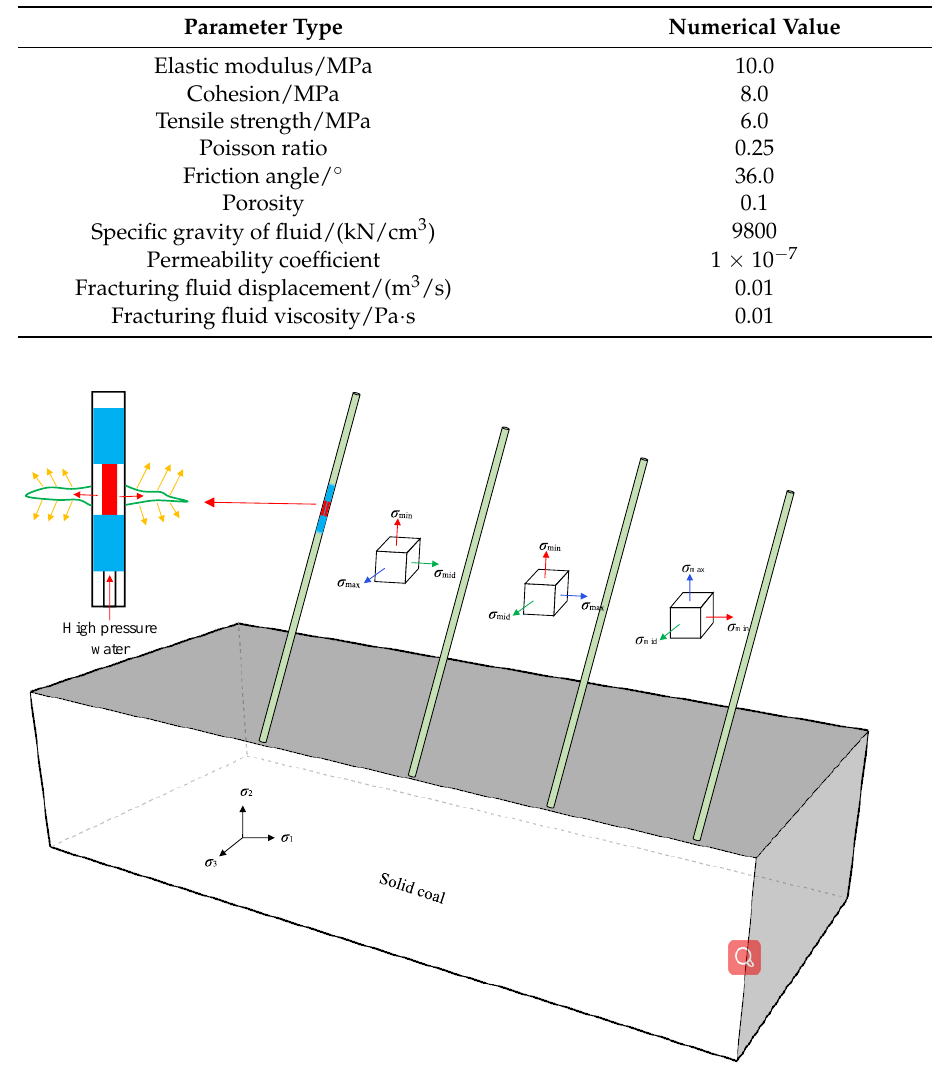
Figure 15. Distribution of stress field.